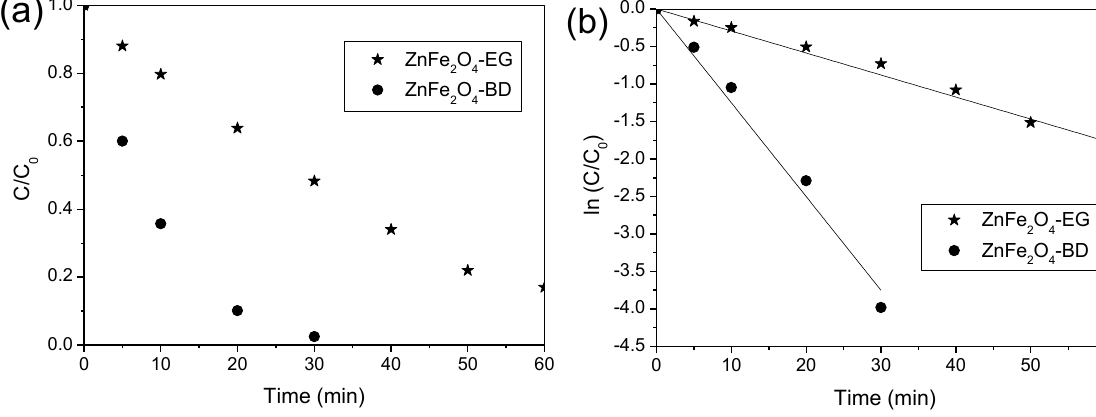
) of Procion red dye over 0 O concentration = 0.04 mol·L −1 2 2